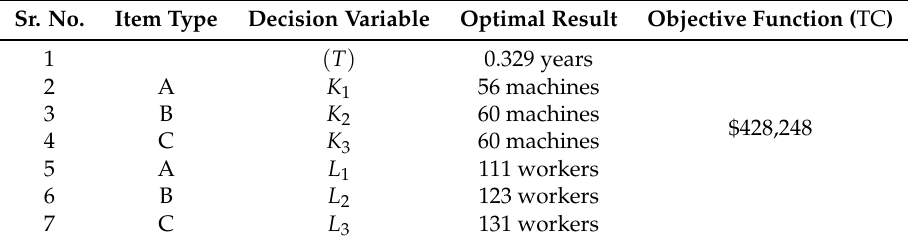
Table 4. Optimal solution of the production